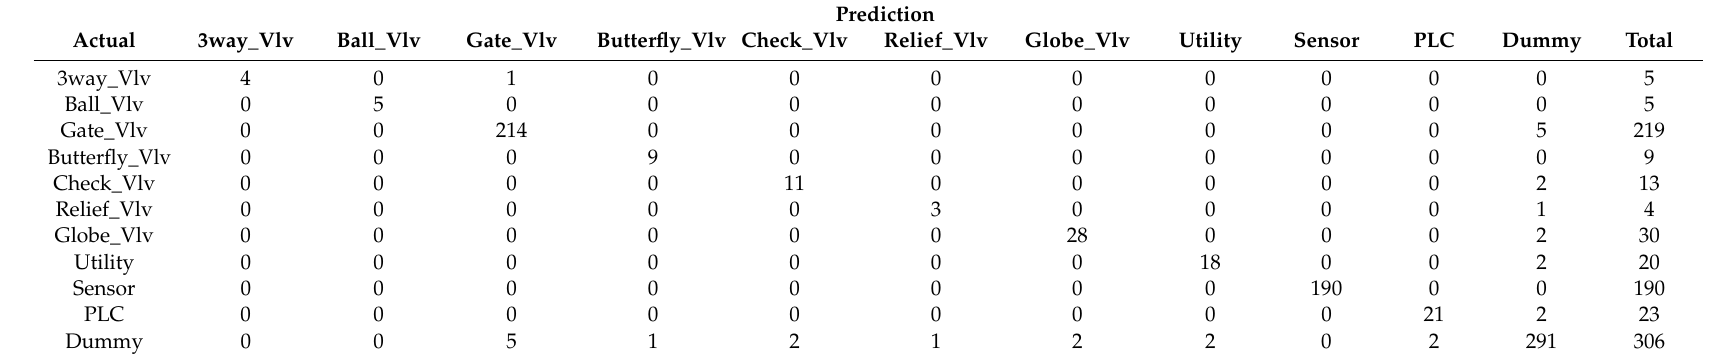
Table 3. Confusion matrix: PN_DAC